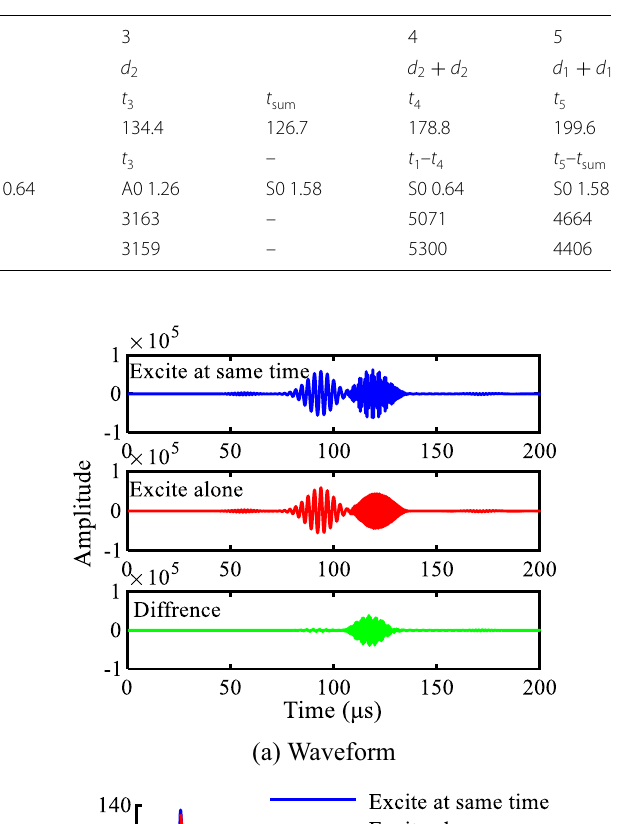
Table 3 Analysis process and results for each echo